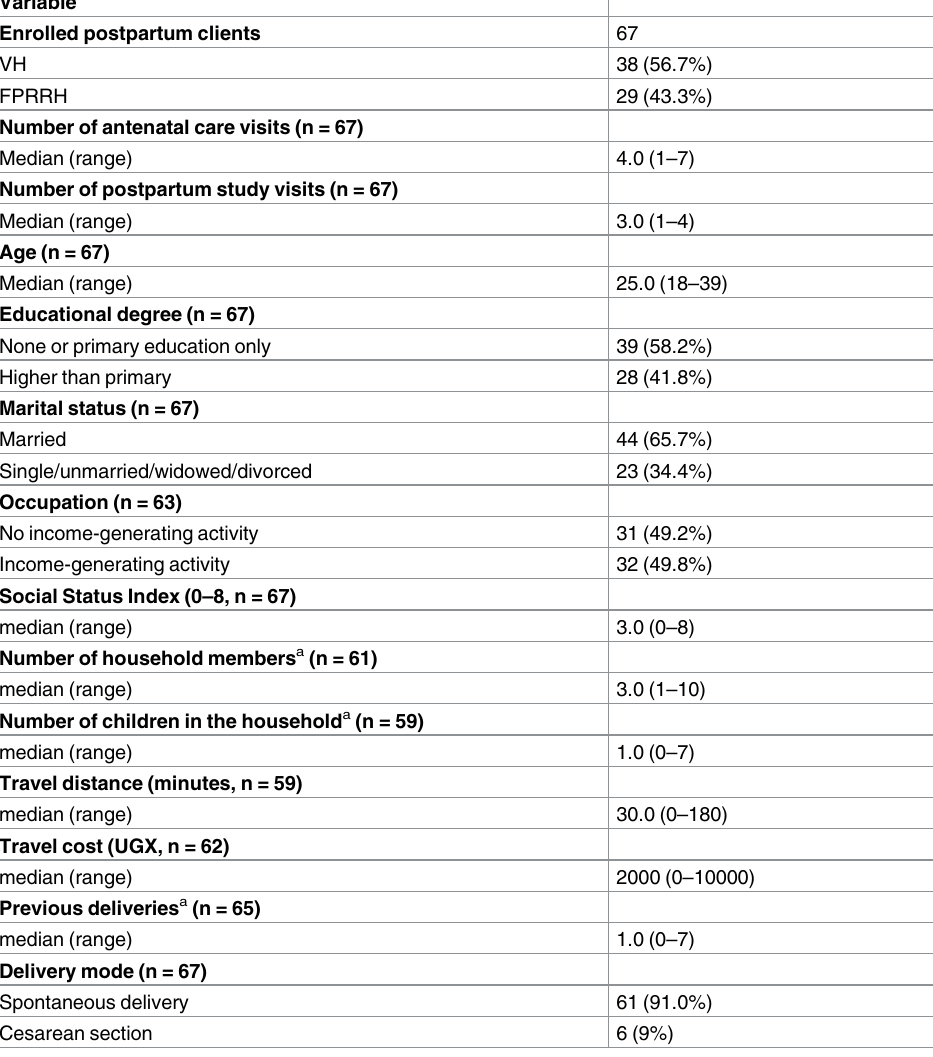
Table 1. Sociodemographic and clinical characteristics of the study